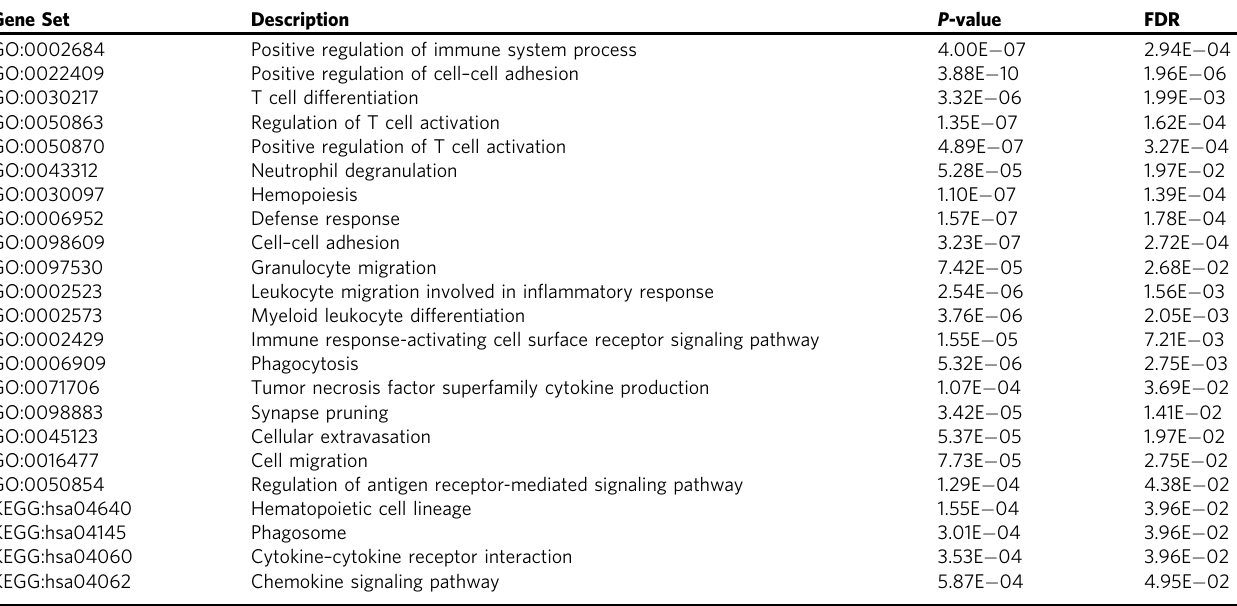
Table 4 Gene set enrichment analysis of signi fi cant methylation differences associated with AD Braak stage identi fi ed in meta- analysis using Wallenius ’ noncentral hypergeometric test which adjusted for different number of CpGs associated with each